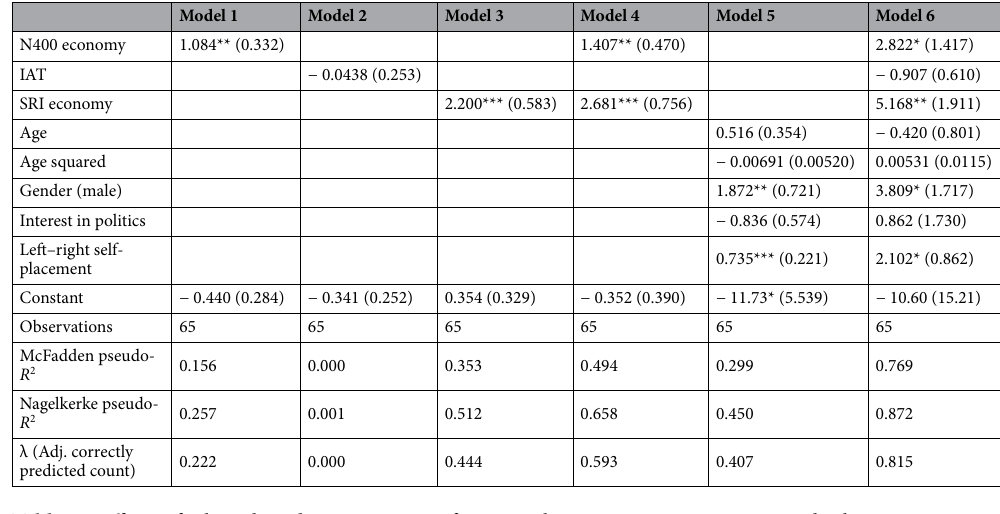
Table 1. Effects of selected predictors on voting for a populist or mainstream party. Standard errors in parentheses; * p < 0.05, ** p < 0.01, *** p <